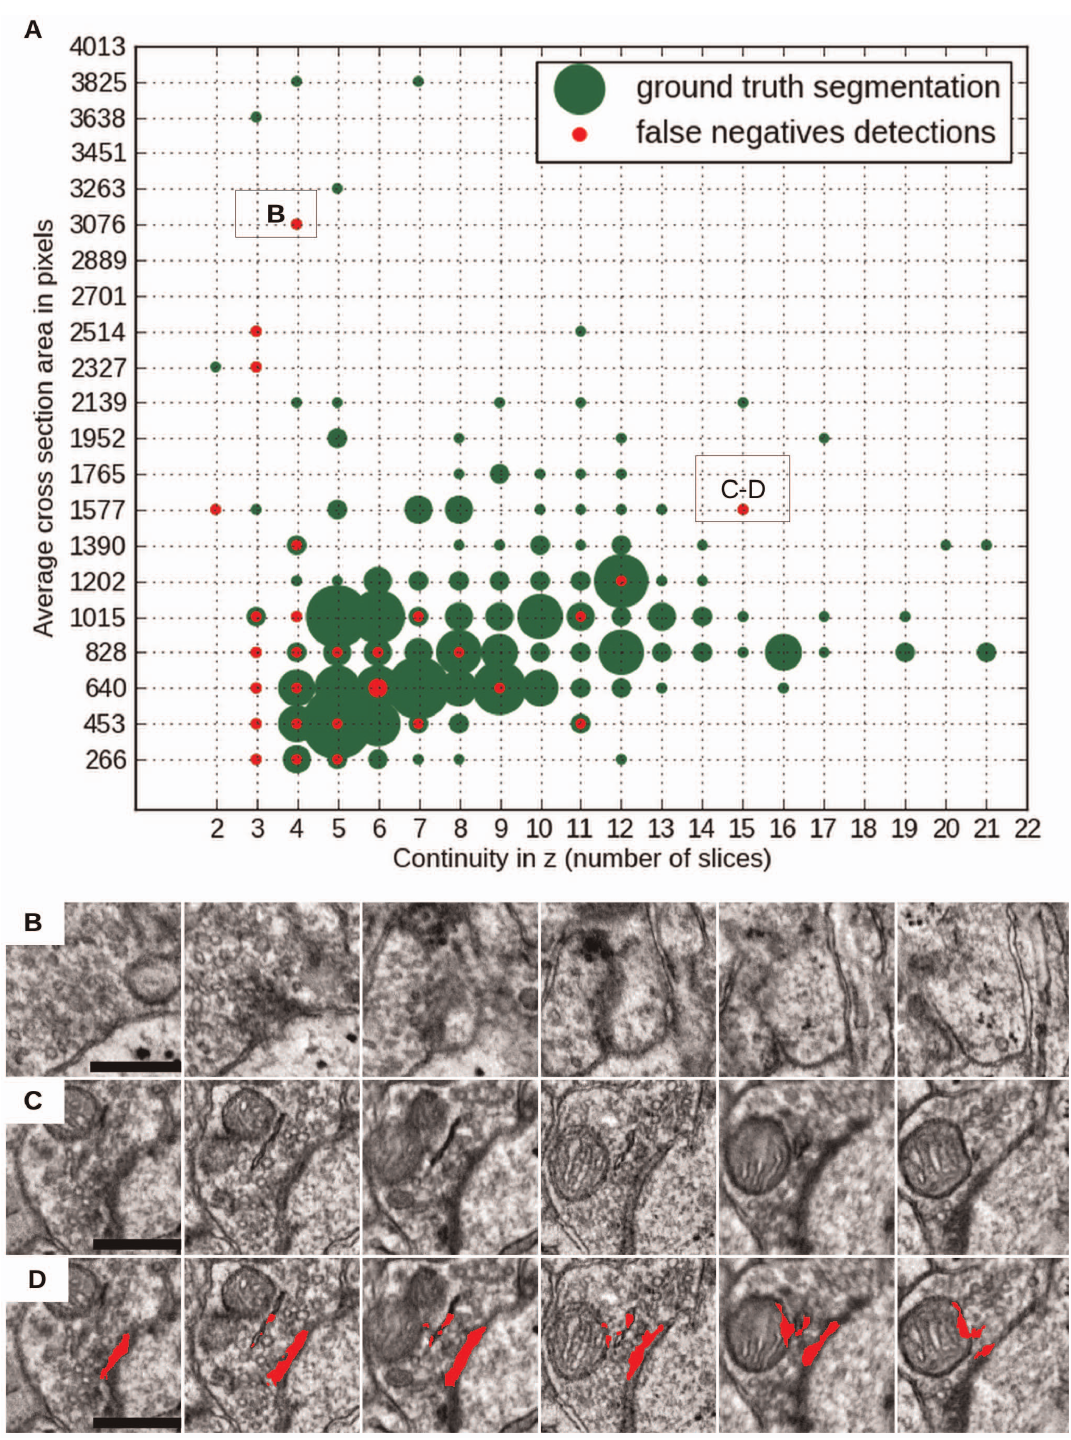
Figure 2. False negative errors. A - distribution of false negative errors as a function of the synapse average cross section area and continuity in z. For each bin of the 2D histogram its count is proportional to the radius of the displayed circle. Cross section area was measured in pixels and averaged across 5 central slices. B, C - serial sections of false negative detections. D – erroneous algorithm segmentation. All scale bars – 450 nm.